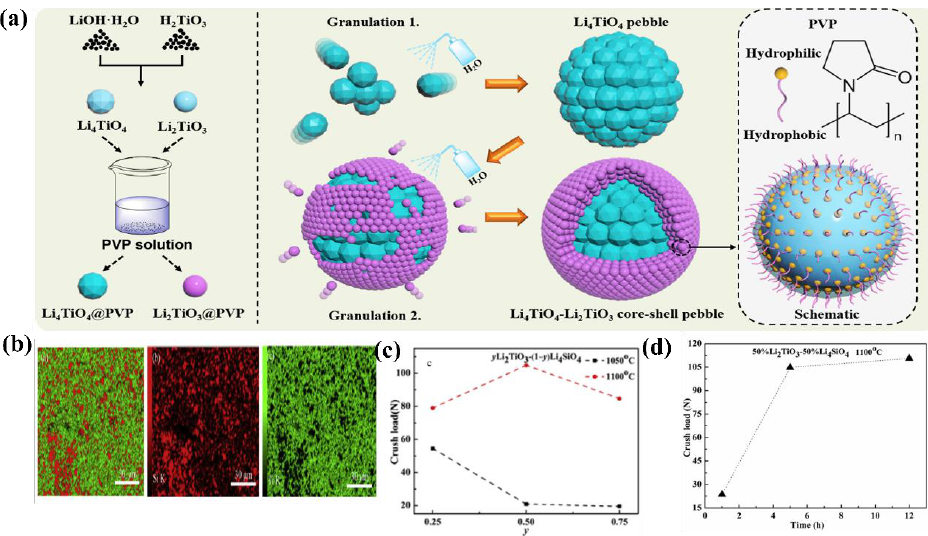
Figure 13. ( a ) Schematic diagram of PVP – assisted fabrication of Li 4 TiO 4 – Li 2 TiO 3 core – shell pebbles. Reprinted with permission from ref. [134]. ( b ) EDS element mapping of 50% Li 2 TiO 3 – 50% Li 4 SiO 4 , Si (red), and Ti (green). ( c ) The crush load of yLi 2 TiO 3 –(1−y)Li 4 SiO 4 pebbles. ( d ) The average crush load of 50% Li 2 TiO 3 – 50% Li 4 SiO 4 pebbles sintered at 1100 °C for 1 h, 5 h, and 12 h. Reprinted with permission from ref. [135].